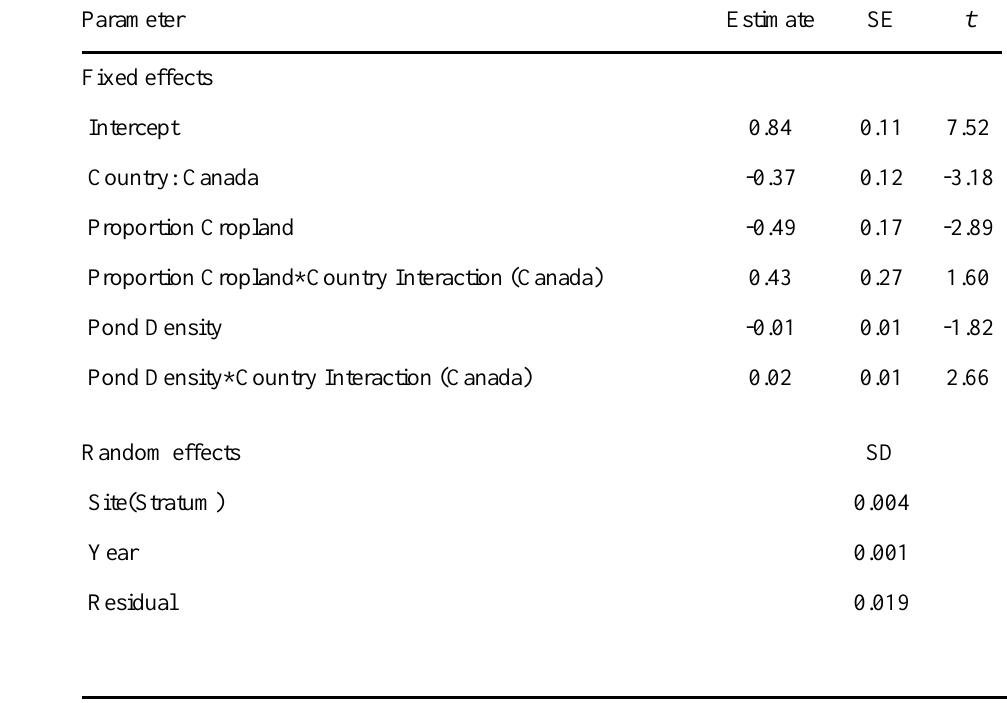
Table 4 . Model-averaged parameter estimates based on 12 general mixed linear models for nest success of dabbling ducks as a function of country, proportion cropland, pond density, and interactions in the North American Prairie Pothole Region between 1964 and 1995. SE refers to standard error, SD to standard deviation, and t = estimate/SE. Parameters in which t > 1.96 have 95% confidence intervals that do not include